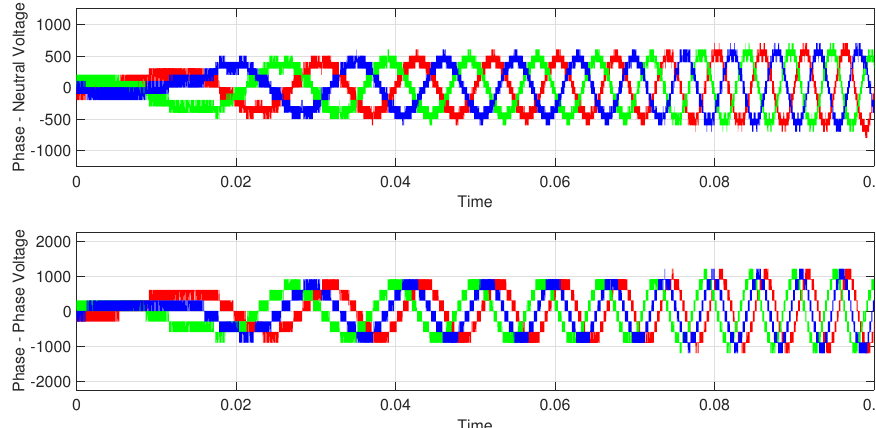
Figure 13. Three-phase output voltage waveforms under VVVF control.